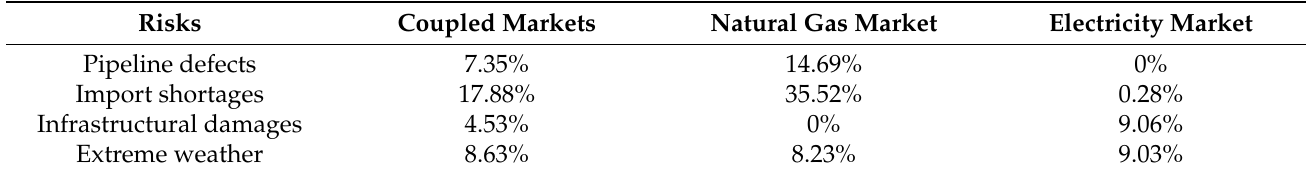
Table 2. Market satisfaction losses induced by individual